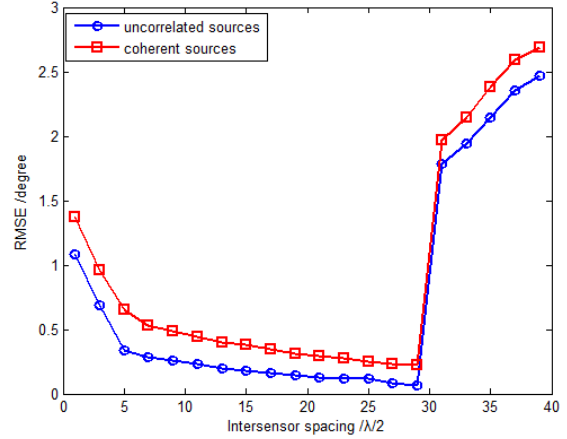
Figure 5. RMSE versus inter-sensor spacing with fixed SNR 15 dB and snapshot number 500.